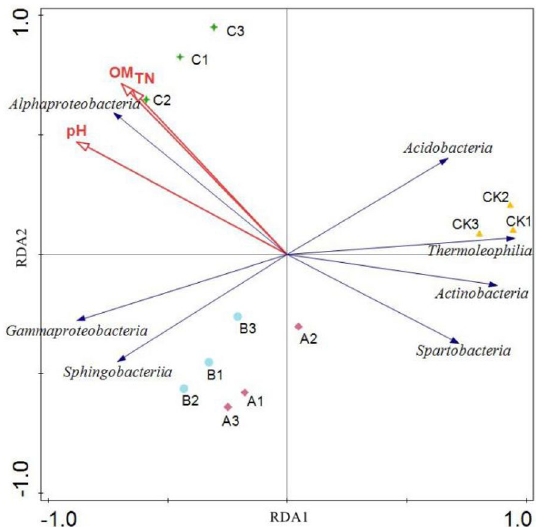
Figure 8. Redundancy analysis of soil bacteria community and soil physicochemical factors. Environmental factors including the pH value, soil organic matter (OM) and soil total nitrogen